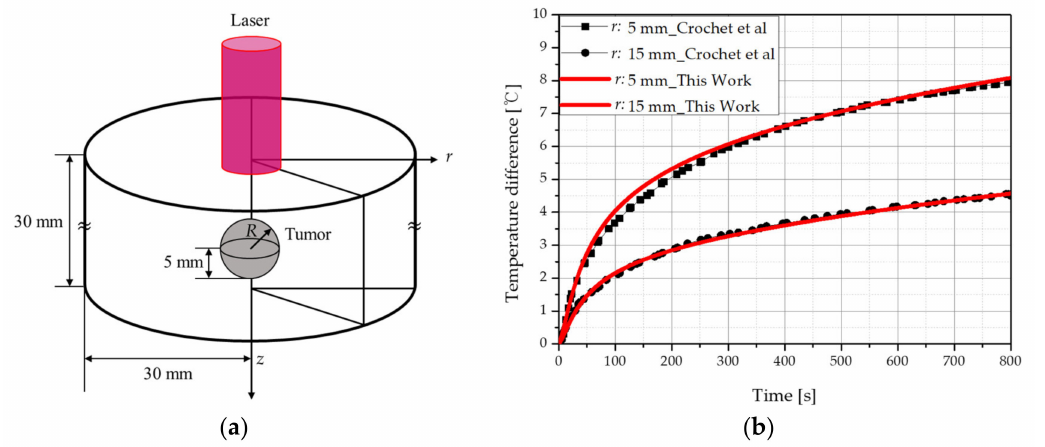
Figure 6. ( a ) Schematic of validation numerical simulation. ( b ) Numerical validation result. Valida- tion of numerical analysis (with previous studies)